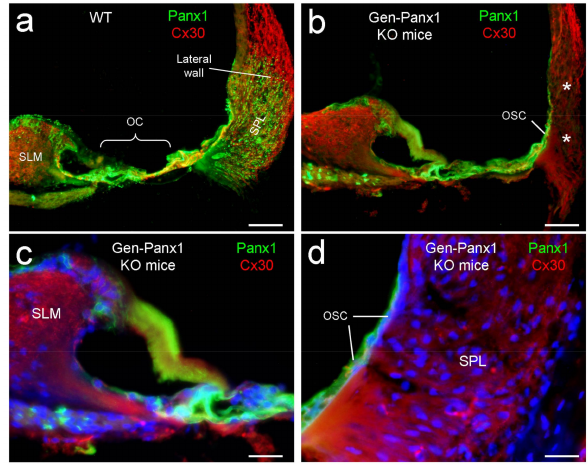
Figure 1. Deletion of Panx1 in the cochlea of Gen-Panx1 knockout (KO) mice. ( a ): Double immunofluorescent staining for Panx1 (green) and Cx30 (red) in the wild-type (WT) mouse cochlea. ( b – d ): Panx1 expression and deletion in the cochlea of Gen-Panx1 KO mice. White asterisks in panel ( b ) indicate the absence of Panx1 labeling at the spiral ligament (SPL) in the lateral wall of the Gen-Panx1 KO mice. OC: organ of Corti; OSC: outer sulcus cell; SLM: spiral limbus. Scale bars: ( a , b ): 50 µ m, ( c , d ): 25 µ